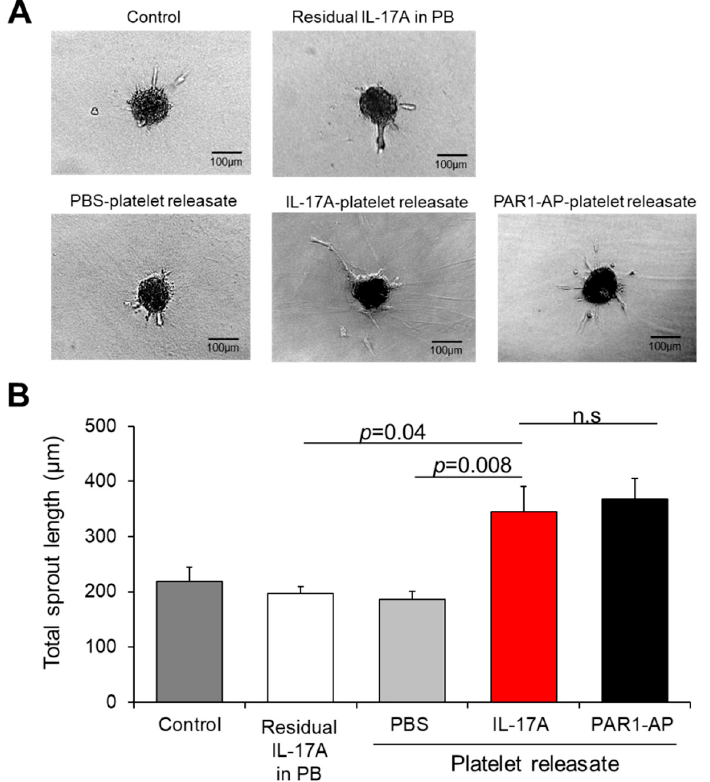
Figure 4. IL-17A platelet releasate triggers sprouting of endothelial cells. ( A ) Endothelial cell spheroids embedded into collagen gel were incubated with medium (untreated ECs), residual IL-17A alone in platelet buffer (at a final concentration of 5 ng/mL) or releasate from platelets induced with IL-17A (50 ng/mL), PAR1-AP (100 μΜ ) or PBS (resting platelets) for 24 h. One representative picture of each group is shown. ( B ) Quantitative analysis of the mean of the total sprout length of at least ten spheroids per experimental group and per experiment was performed. Data are shown as mean of the total sprout length ( μ m) ± SEM of six independent experiments. With regard to statistics, adjusted p -value as determined by one-way ANOVA and Bonferroni’s multiple comparison test is reported per indicated comparison. No statistical significance is denoted as n.s. Scale bars indicate 100 μ m.